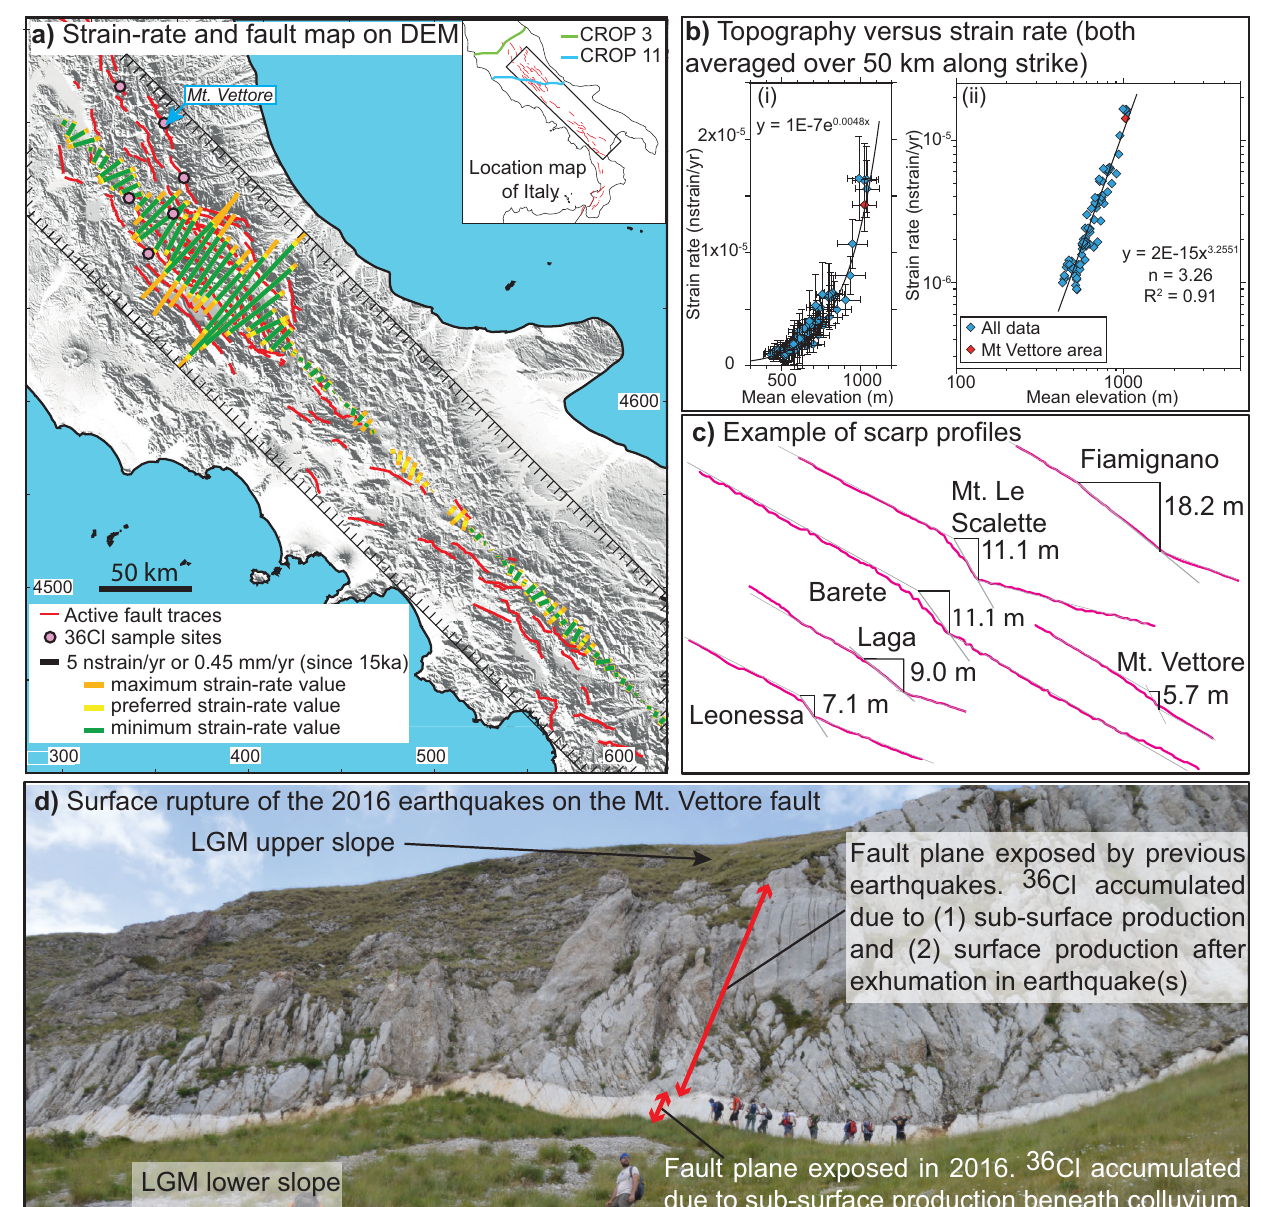
Fig. 1 | Current knowledge of fault and shear zone interaction in the central Apennines. a Map showing the spatial variation in principal horizontal strain rate (maximum, preferred and minimum strain-rate values shown) calculated on a 5×90km grid (delineated by black lines and tick marks) traversing the Italian Apennines (topography from SRTM DEM), derived from the directions and mag- nitudesoffaulted-offsetssince15±3kaoflandformsdatingfromthedemiseofthe Last Glacial Maximum, modi fi ed and updated from ref. 20 The locations of 36 Cl samplesiteanddeepseismicre fl ectiondatasetsmentionedinthetextareindicated in the inset map. b Topography against strain-rate from a , showing a power law